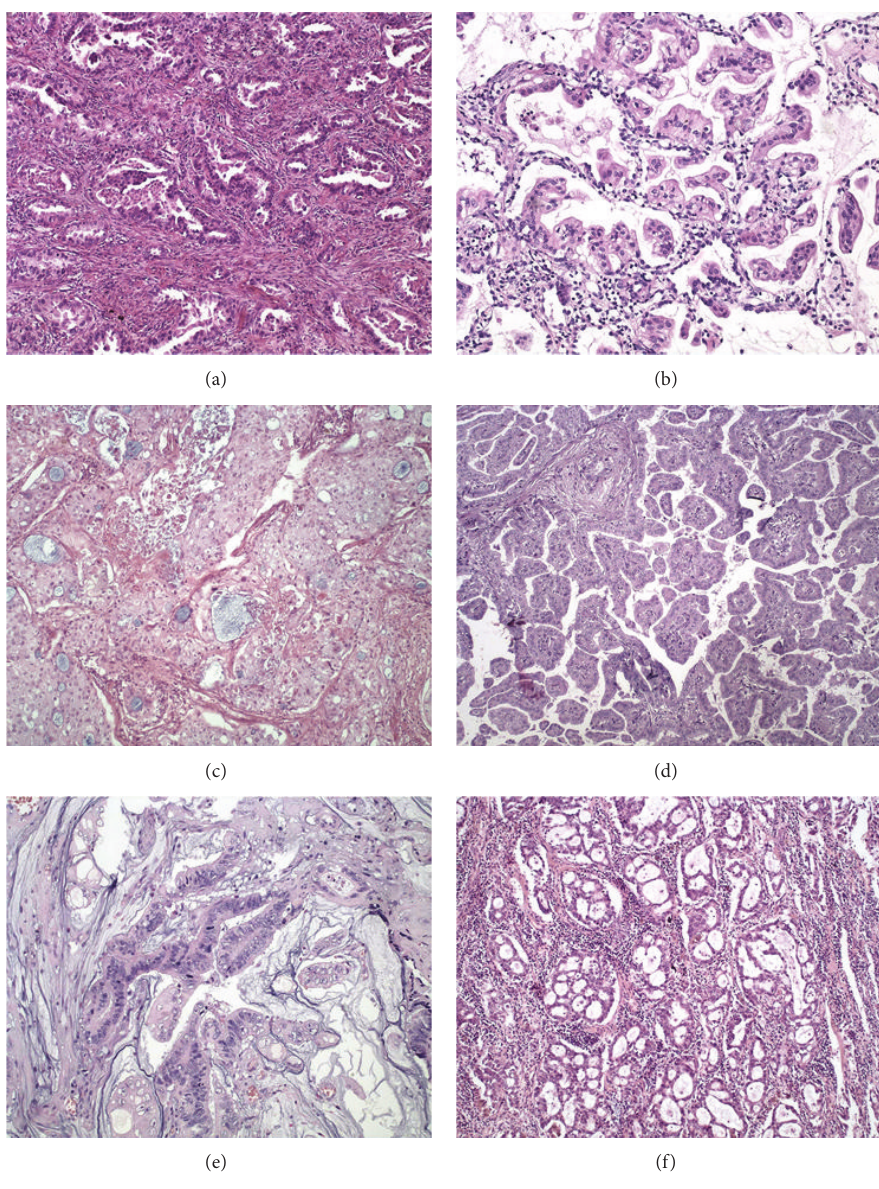
Figure 1: Morphologic features of lung adenocarcinoma according to the predominant growth pattern: (a) acinar; (b) lepidic; (c) solid; (d) papillary; (e) mucinous adenocarcinoma; (f) acinar tumor with prominent cribriform formation. All figures